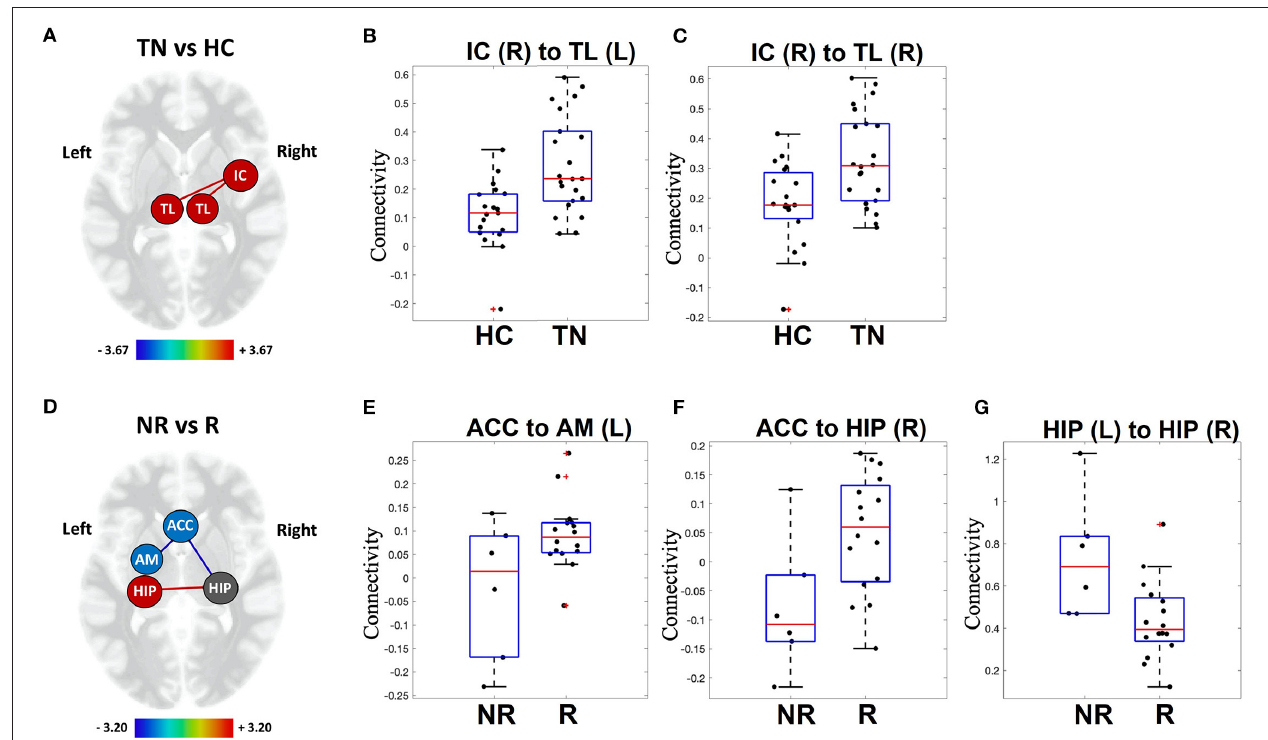
FIGURE 2 | Visual representation of functional connectivity differences. TN patients (TN) vs. healthy controls (HC) : patients with TN show increased resting-state functional connectivity in sensory-relay and salience structures (A) . Individual patient connectivity is displayed on scatter-plot graphs for right insular cortex to left thalamus (B) and right insular cortex to right thalamus connections (C) . Responders (R) vs. Non-responders (NR) : non-responders show altered resting-state functional connectivity in limbic structures (D) . Individual patient connectivity is displayed on scatter-plot graphs for the anterior cingulate cortex to left amygdala (E) and right hippocampus (F) , as well as between the left and right hippocampus (G) . Increased connectivity, red line; decreased connectivity, blue line; TL, thalamus; IC, insular cortex; HIP, hippocampus; AM, amygdala; ACC, anterior cingulate cortex. Heat scales indicate the relative strength of connection between nodes (i.e., edge color). Red crosses represent patients with functional connectivity beyond 1.5 times the group inter-quartile range (IQR).